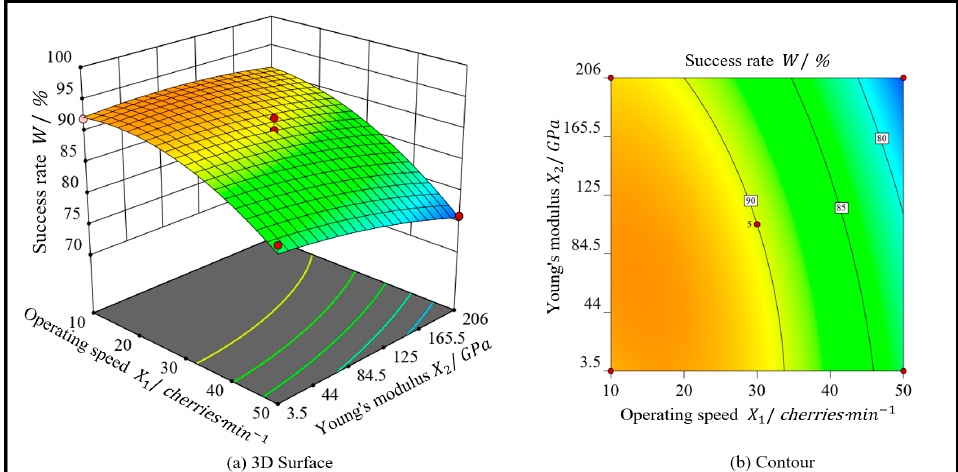
Figure 12. Effects of operating speed and Young’s modulus on success rate of sweet cherries.